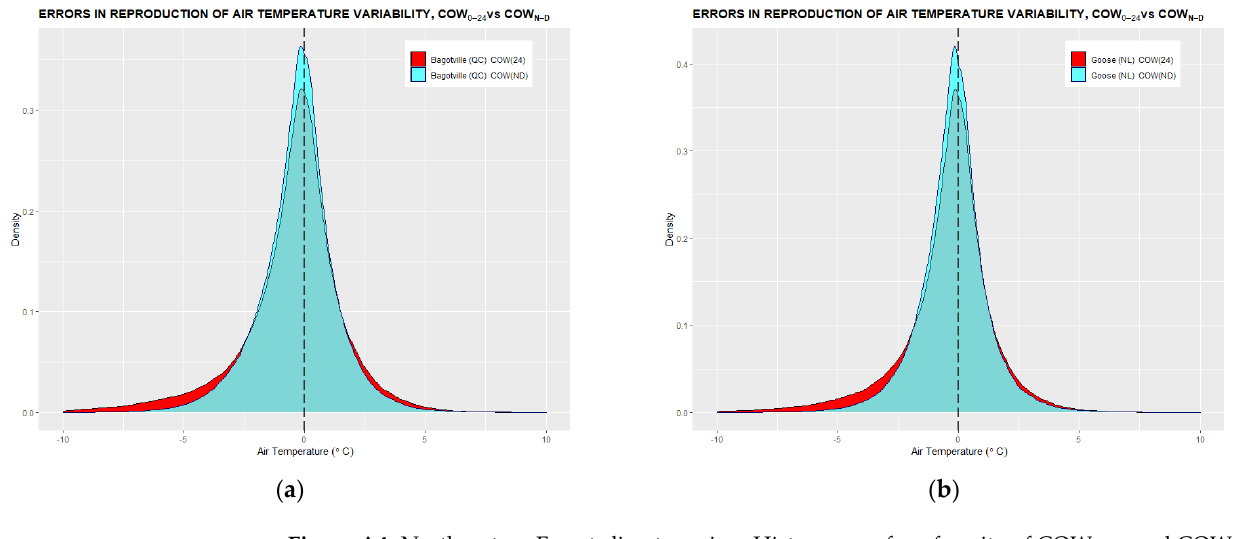
Figure A4. Northeastern Forest climate region. Histograms of conformity of COW 0–24 and COW N–D reproduced temperature with observed hourly temperature data for the 1953–2018 data period at Bagotville ( a ) and Goose ( b ) stations.